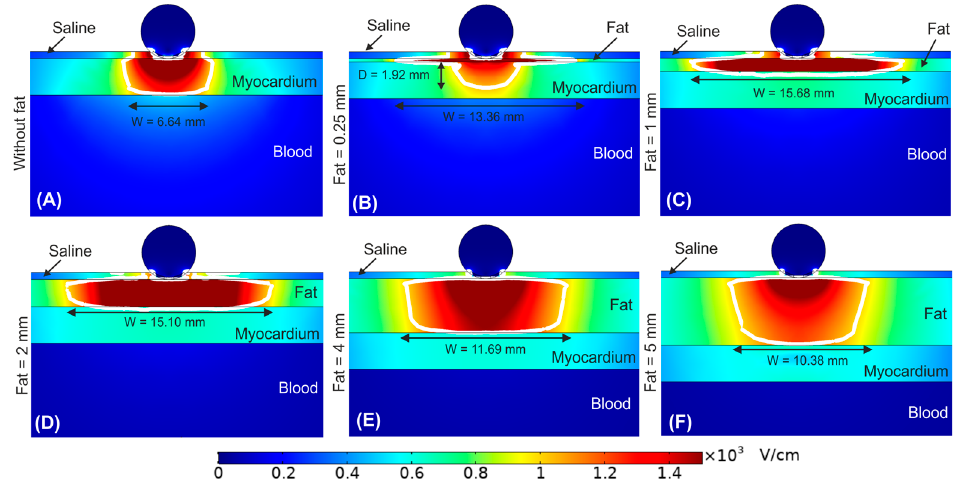
Figure 4. Electric field distribution around the target site (epicardium) to assess the effect of increasing the fat layer thickness. Different fat layer thicknesses were compared: ( A ) without fat layer, ( B ) 0.25 mm, ( C ) 1 mm, ( D ) 2 mm, ( E ) 4 mm, and ( F ) 5 mm fat layers. The ablation device is totally embedded in the saline layer. The white contour corresponds to the 1000 V/cm electric field isoline.